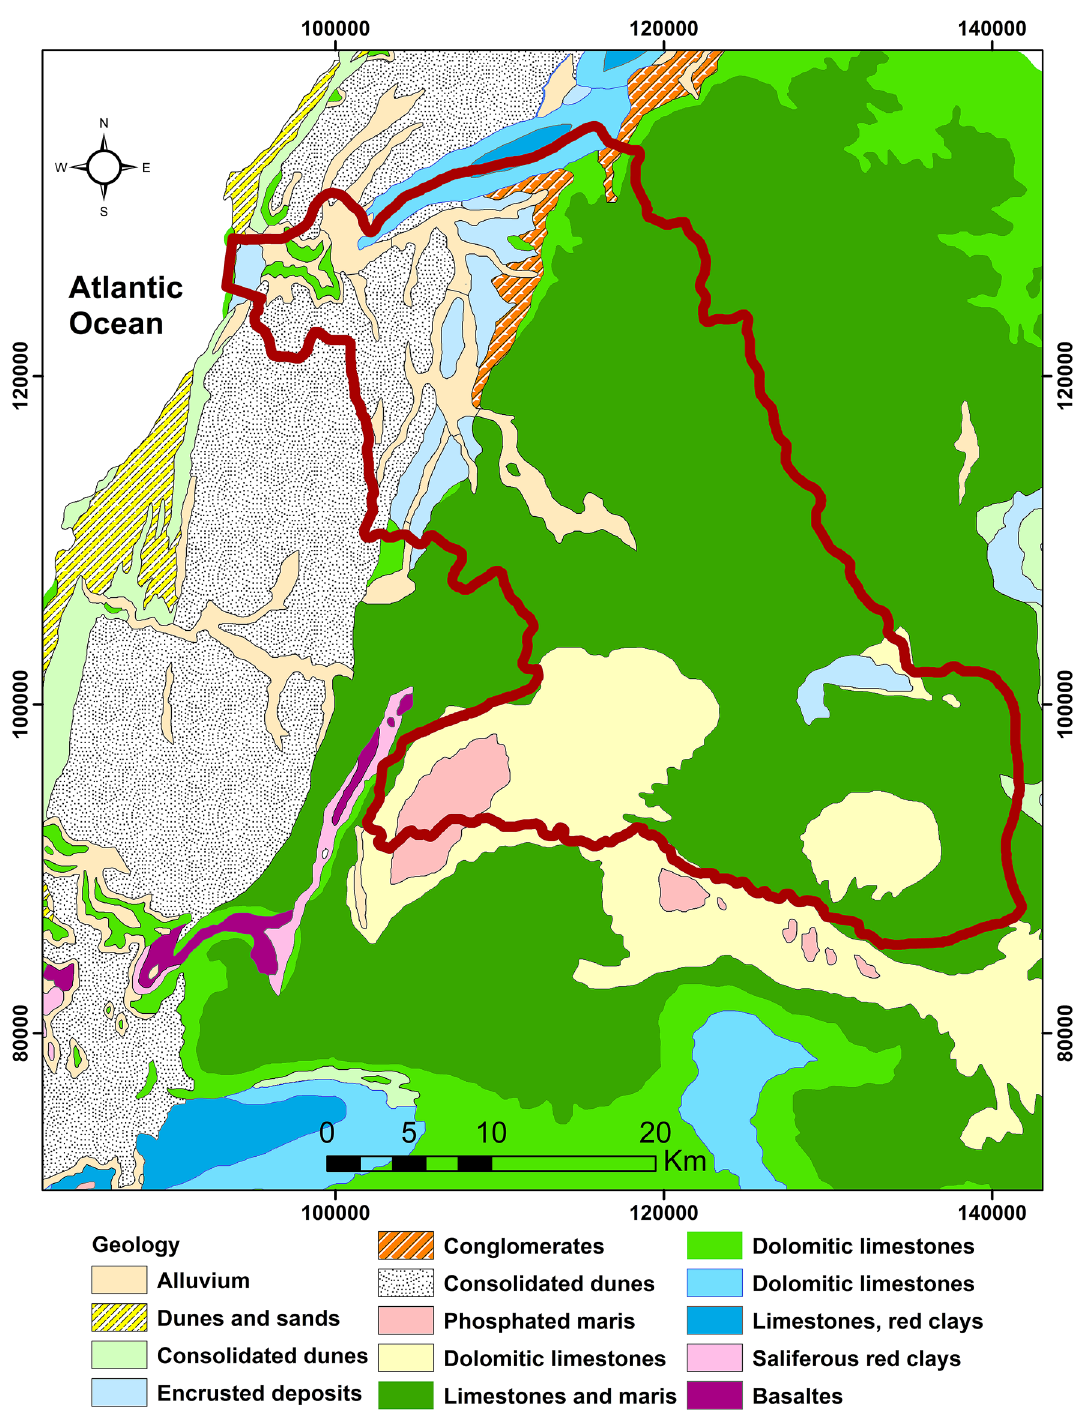
Fig. 2 Geology map in the study